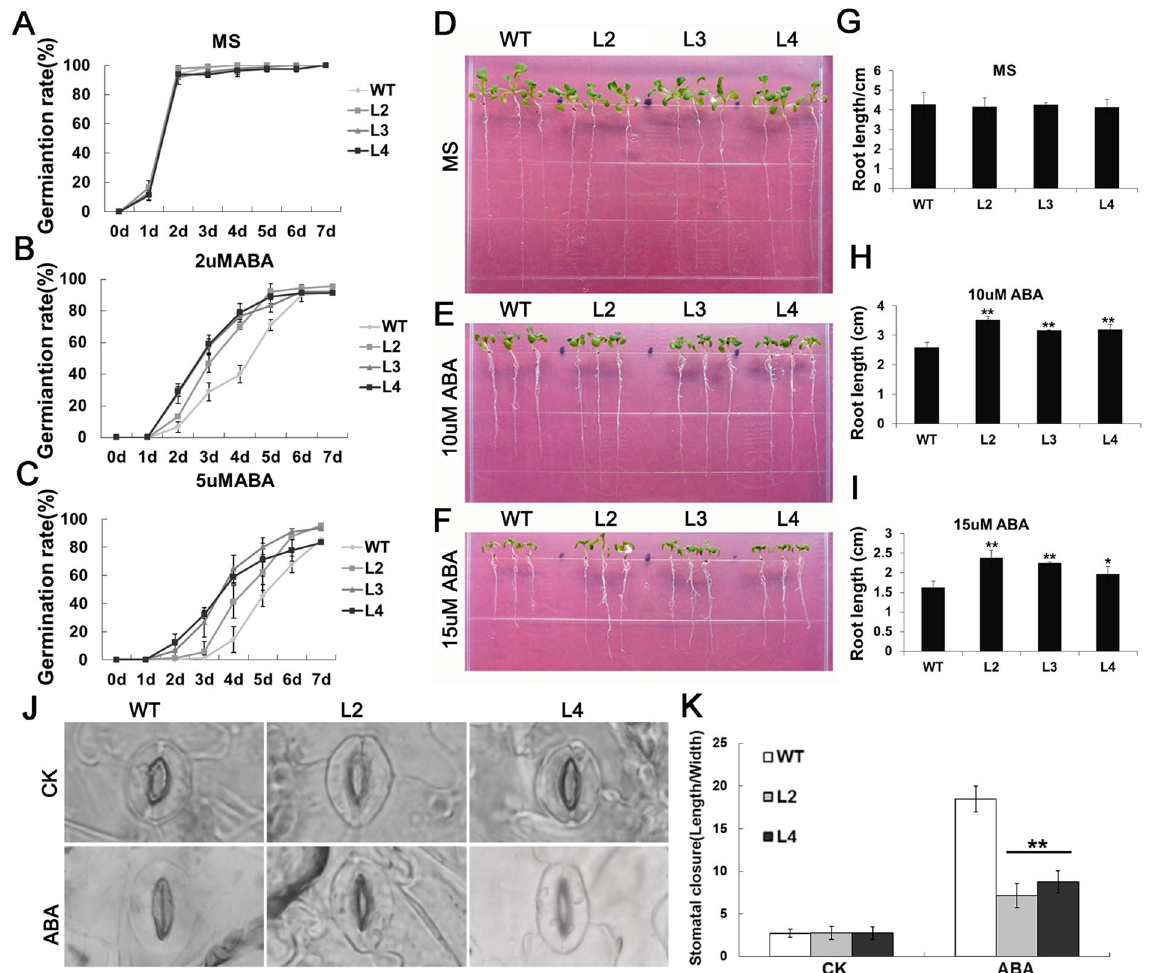
Figure 7. Assay of GhWRKY33 overexpression transgenic Arabidopsis tolerant to ABA. ( A – C ) Seed germination rates of GhWRKY33 transgenic lines and wild type with different ABA concentrations (0, 2 and 5 μ M). Germination was recorded daily. ( D – F ) Seedlings of transgenic lines and wild type with 0, 10 and 15 μ M ABA treatment. ( G – I ) Statistical analysis of the root length of seedlings with 0, 10 and 15 μ M ABA treatment. ( J ) Micrographs of stomatal changes of the transgenic lines and wild type with or without 20 μ M ABA treatment. ( K ) Measurement of statistical analysis of stomatal closure (stomatal length:width ratio) of the transgenic lines and wild type with or without ABA treatment (n > 40 for each sample). Mean values and standard errors (bars) are shown from three independent experiments. One and two asterisks represent there was a significant difference (P < 0.05) and a very significant difference (P < 0.01) in Duncan’s multiple range test, respectively. CK, seedlings grew under normal conditions as controls; ABA, seedlings grew with 20 μ M ABA treatment; WT, wild type; L2, L3 and L4, three GhWRKY33 overexpression transgenic